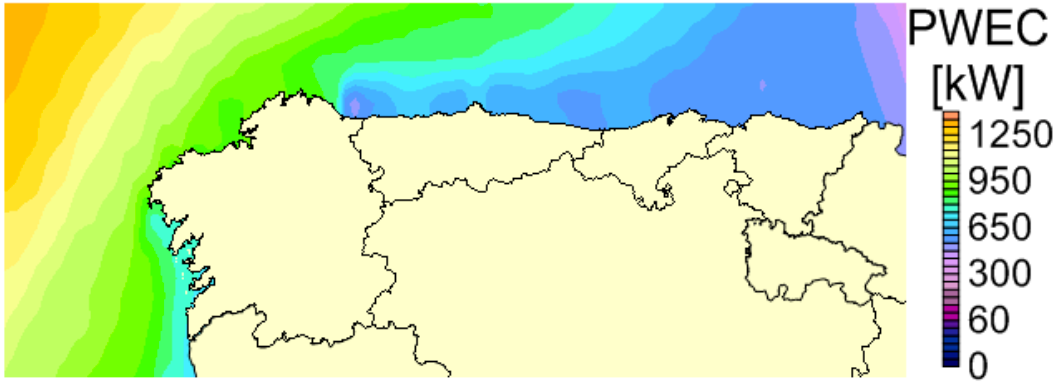
Figure 8. Power of AquaBuoy.